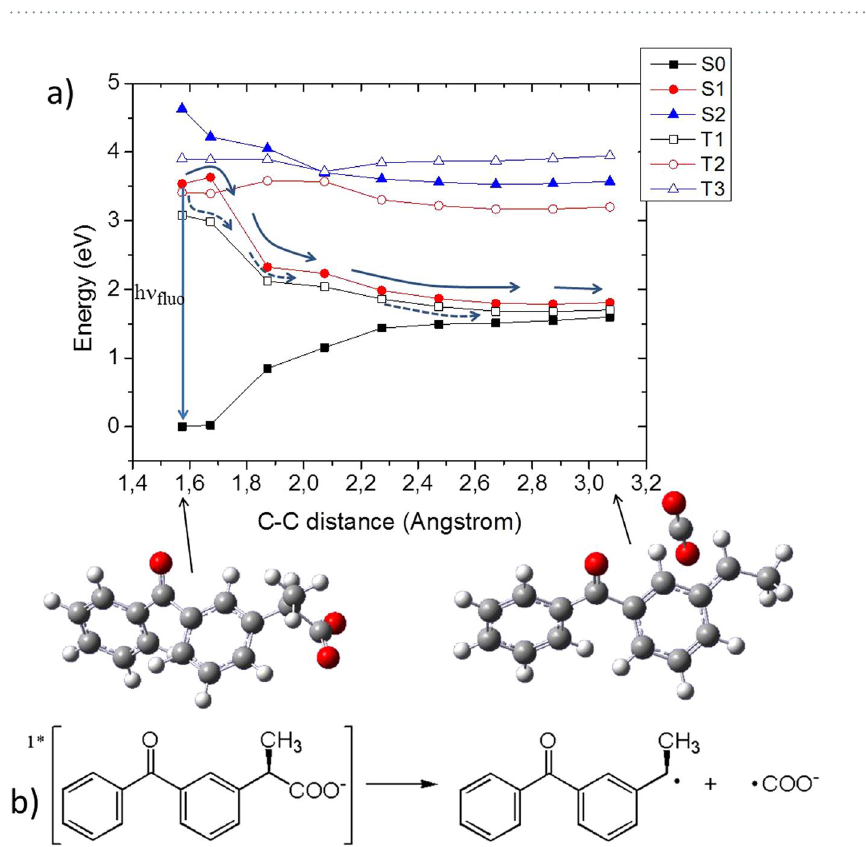
Figure 6. ( a ) CASPT2//CASSCF MEP of ketoprofen in the S 1 and T 1 state, shown as a function of the photo- dissociation coordinate. TD-DFT and CASSCF results are provided in Supplementary Information and give the same global picture. ( b ) Reactants and products are displayed, including the chemical